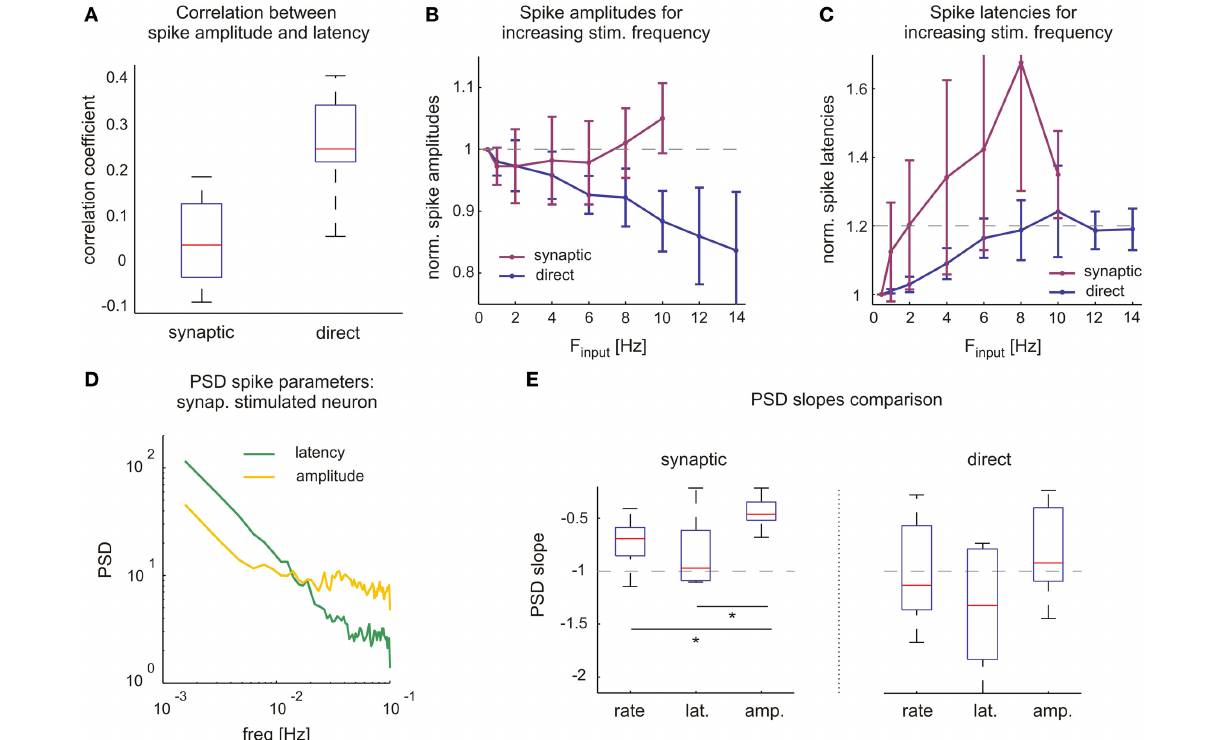
around 120% of their initial values, while synaptic mediated response latencies increase with stimulation frequencies. Neurons and analysis like for spike amplitudes, middle panel. (D) Comparing power spectral density of spike latencies (green) and amplitudes (yellow) of an individual neuron stimulated synaptically. Values were normalized by SD to omit possible offsets. (E) Estimated PSD slopes of long-term stimulation experiment values. PSD slopes of direct response parameters vary close to − 1, indicating 1 / f characteristics. For synaptic mediated responses the same is true in spike rate and latency, however PSD slopes of spike amplitude ( − 0.45 ± 0.15, mean ± SD ) differ significantly ( t -test with p -value < 0.02 comparing to both latency and rate). Slope estimates were performed with linear regression of logarithm of the